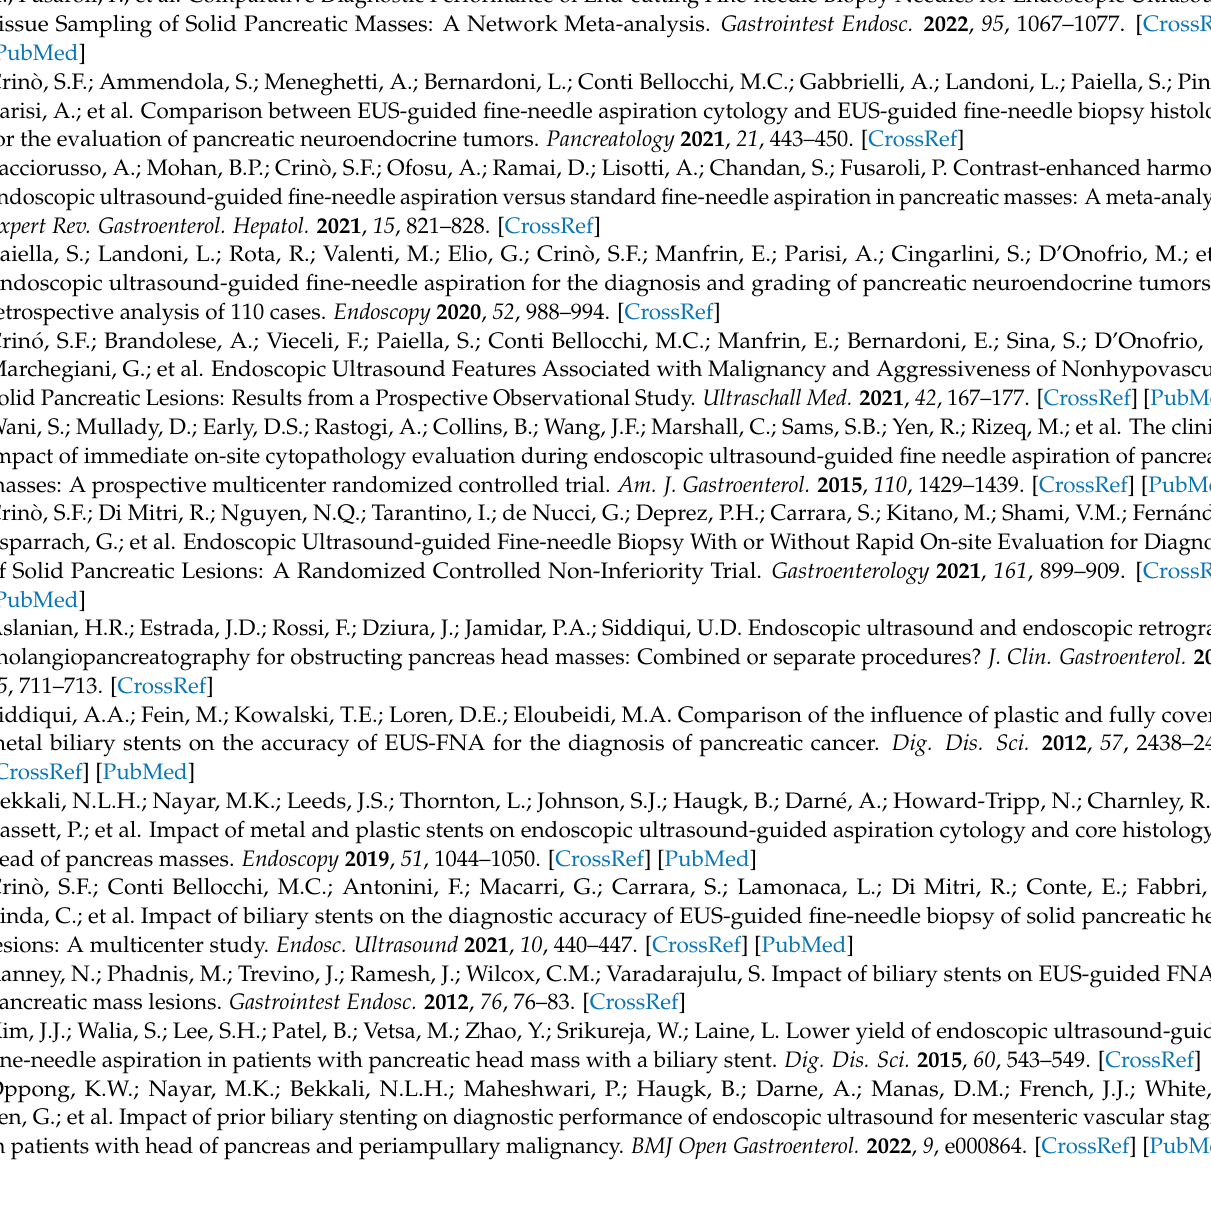
Table S2: Risk of bias assessment and quality of included studies. Table S3: Adverse events reported in the included